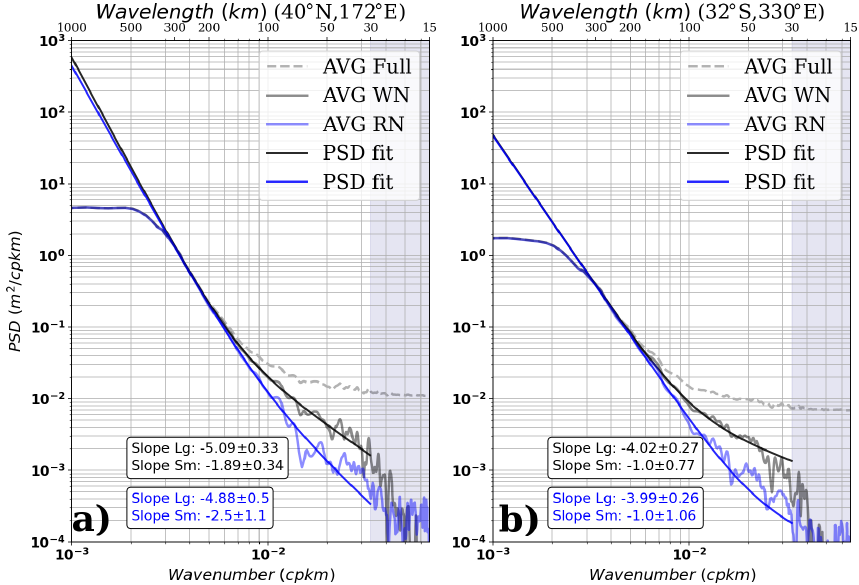
Figure A1. Result of the double-fit algorithm over the denoised S3A data for the white (black-WN) and red (blue-RN) noise model for a 12 ◦ × 12 ◦ box over the North Pacific (a) and the South Atlantic (b) . Considering the error associated with the optimal fit analysis, the spectral slopes obtained for either the black or blue curves are not significantly different.